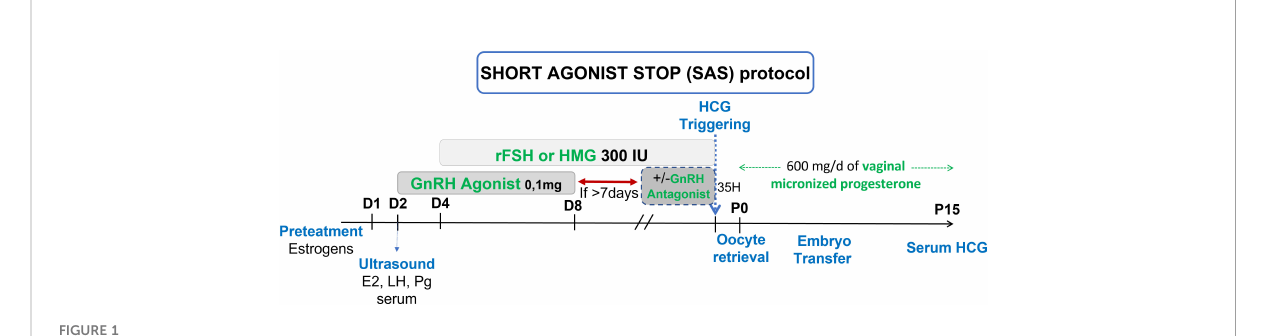
FIGURE 1 Short agonist stop (SAS) stimulation